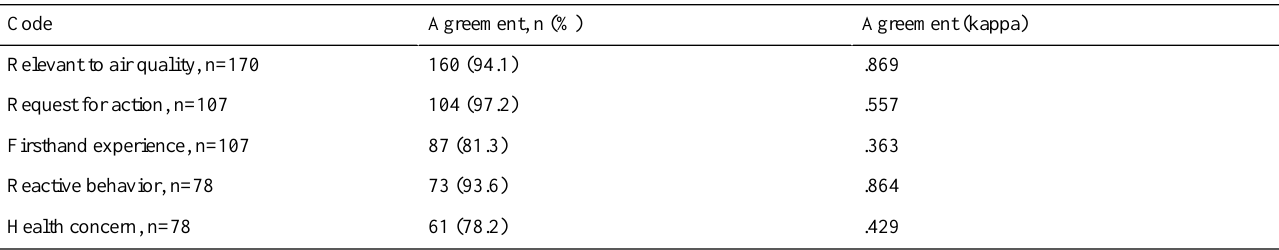
Table 2. Percentage of annotated messages matching the criteria, along with annotator agreement statistics for each question.